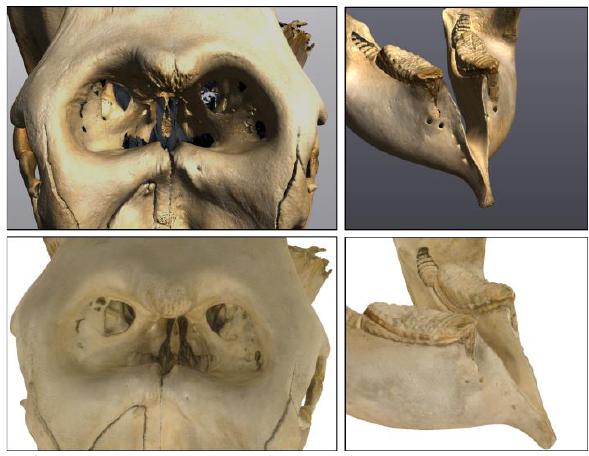
Figure 11. Detailed view of the skull recorded with hand-held scanner (top) and SfM (bottom).